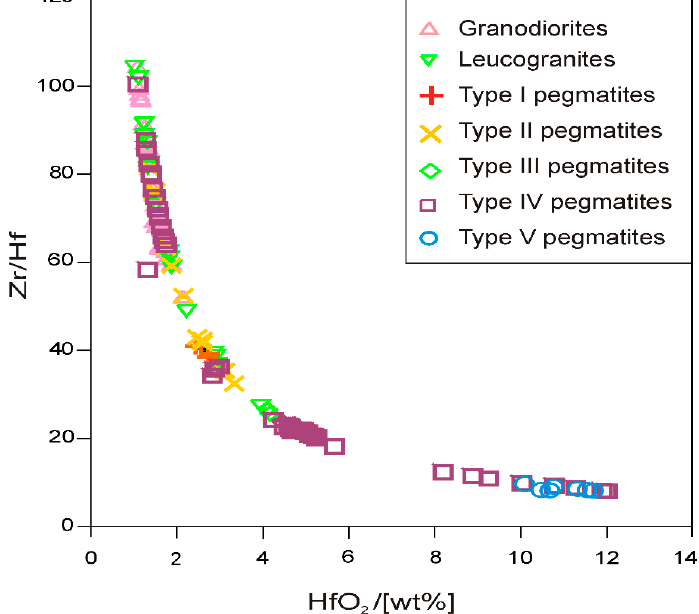
Figure 23. Evolution of the composition of the zircon crystals from the granitic rocks towards the most evolved